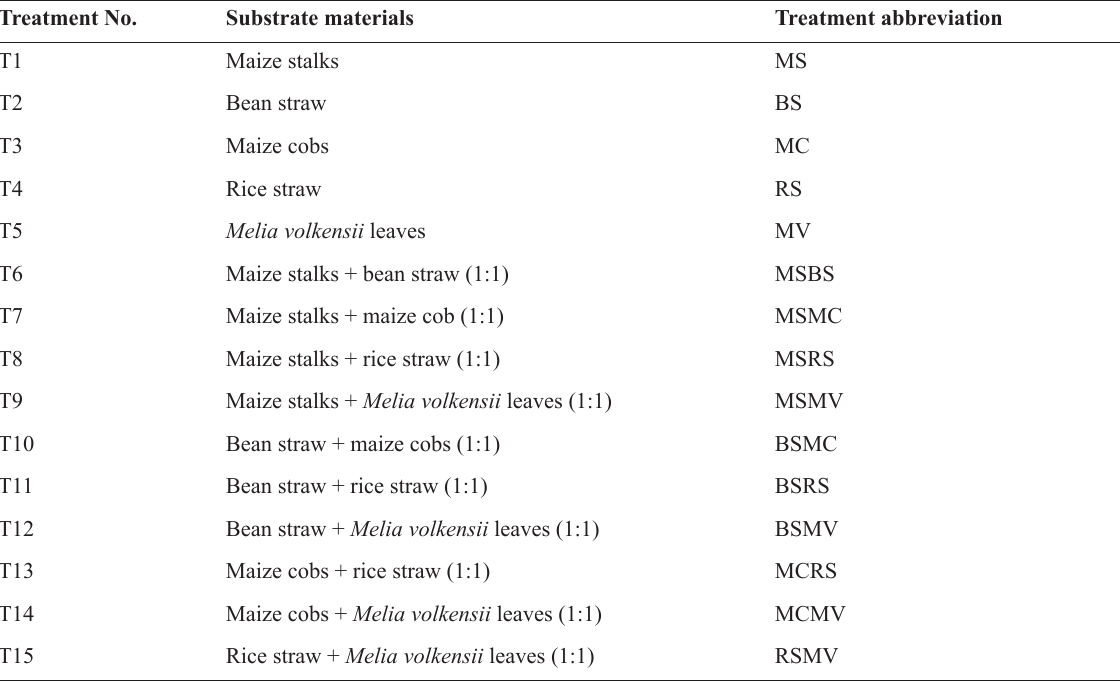
Table 1 Treatments of substrate and their combinations Treatment